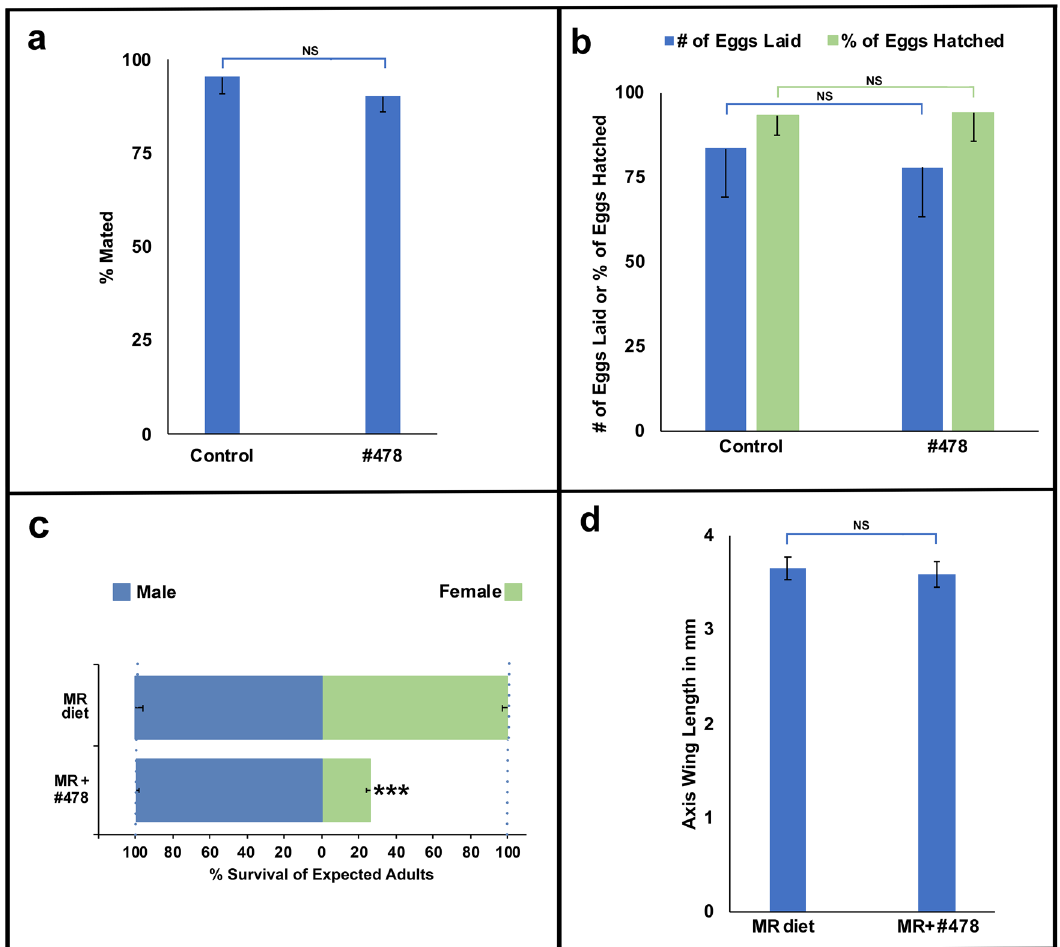
Figure 3. Yeast interfering RNA larvicide technology can be used for scaled production of males. Yeast larvicide #478 does not significantly impact male mating capacity [( a ), p > 0.05, Student’s t-test], the number of eggs laid by females that mated with these males [( b ), p > 0.05, Student’s t-test], or the percentage of larvae that hatched from these eggs [( b ), p > 0.05, Student’s t-test]; results were compiled from 41 matings with #478-treated males and 72 matings with males treated with control interfering RNA yeast). Incorporation of the yeast larvicide into a larval diet used for mass-rearing (MR; n = 1200 total larvae per treatment) resulted in significant female mortality [( c ), *** = p < 0.001, Chi-square] with no significant impact on male survival [( c ), p > 0.05, Chi- square] or fitness [( d ), p > 0.05, Student’s t-test; n = 83 control diet male wings, n = 40 #478-treated male wings]. Error bars denote SEM in all